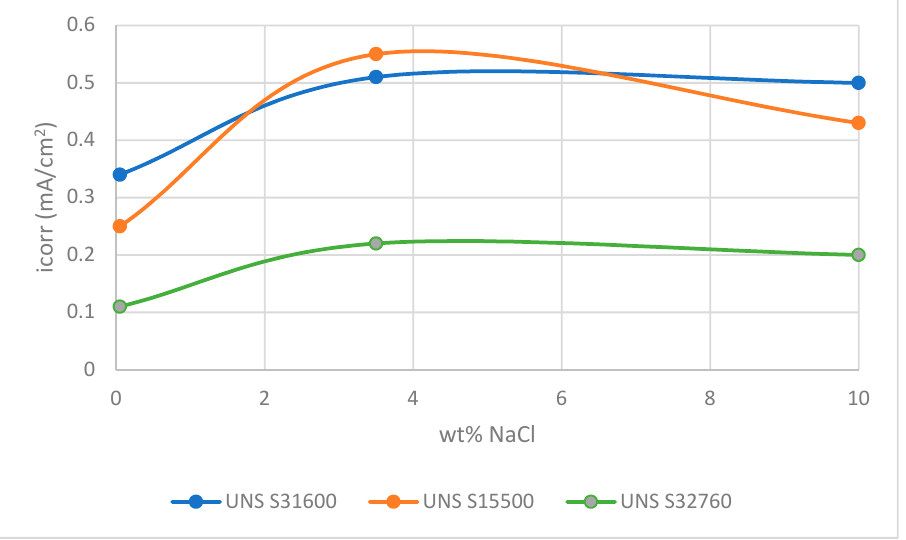
Figure 17. Trends in corrosion rate of directly-impinged zone.